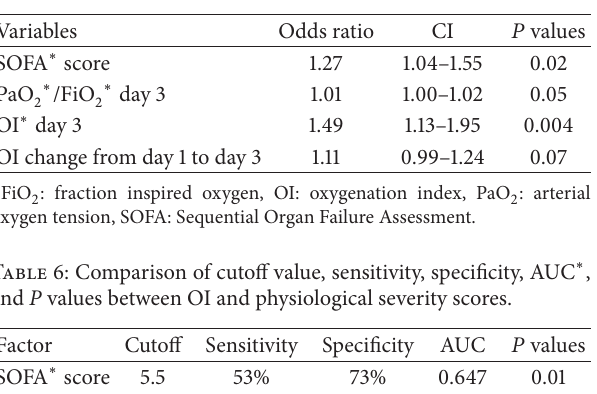
Table 5: Multivariate analysis of predictors of hospital mortality in patients with severe acute respiratory failure.